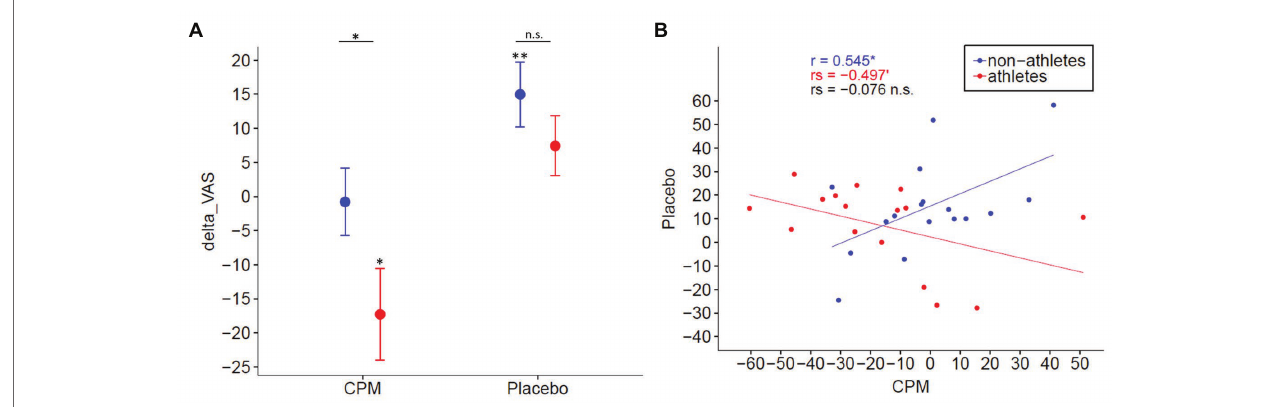
FIGURE 6 | Dissociation of CPM and placebo. (A) Mean and standard error of CPM and placebo effects in nonathletes (blue) and endurance athletes (red). A negative value represents CPM-induced hypoalgesia, whereas a positive value represents placebo-induced hypoalgesia. The CPM effect was greater [ t (32) = − 1.983, p = 0.023, one-tailed] in athletes than in nonathletes. In contrast, a significant placebo effect was only observed in nonathletes [ t (15) = 3.148, p = 0.006], but not in athletes [ t (14) = 1.690, p = 0.111]. (B) Association between CPM effect and placebo effect. Whereas a positive association between CPM and placebo effects [ r (15) = 0.545, p = 0.02] was present in nonathletes, a negative trend was observed in athletes [ r s(14) = − 0.497, p = 0.052], indicating that CPM and placebo might be constituted by, at least partially, different mechanisms [ r s(31) = − 0.076, p = 0.672]. VAS, visual analog